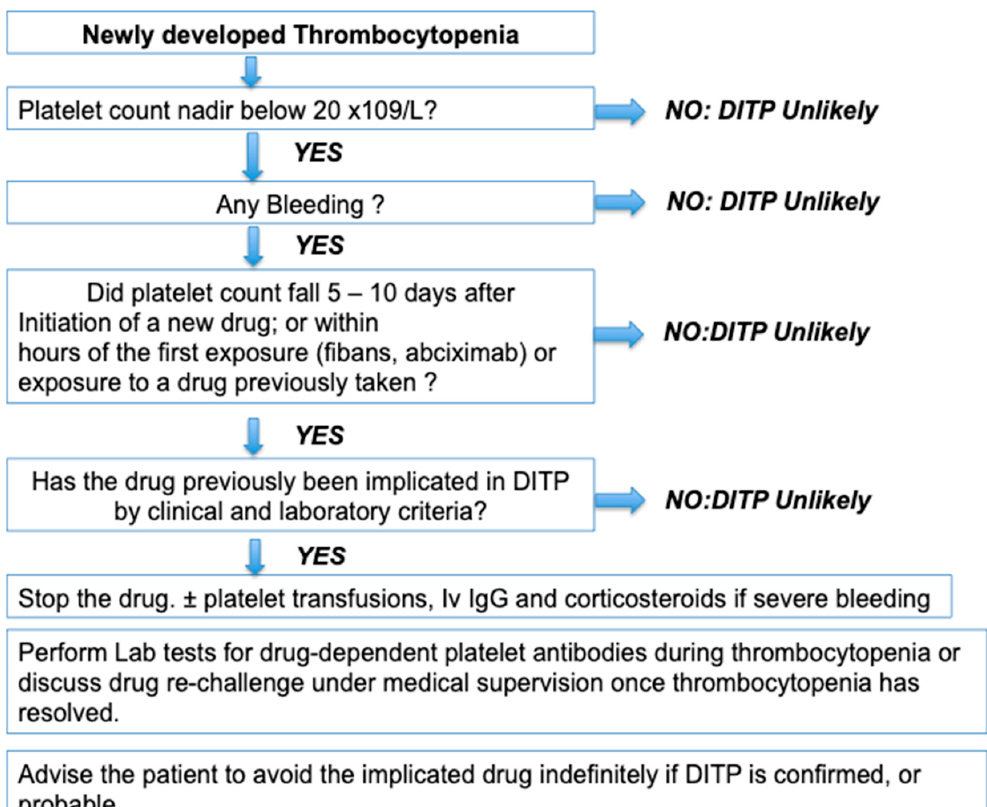
Figure 2. Practical approach for the diagnosis of DITP, adapted from Arnold et al. 2013 [5]. DITP: drug-induced immune thrombocytopenia; Iv Ig: Intravenous immunoglobulins.